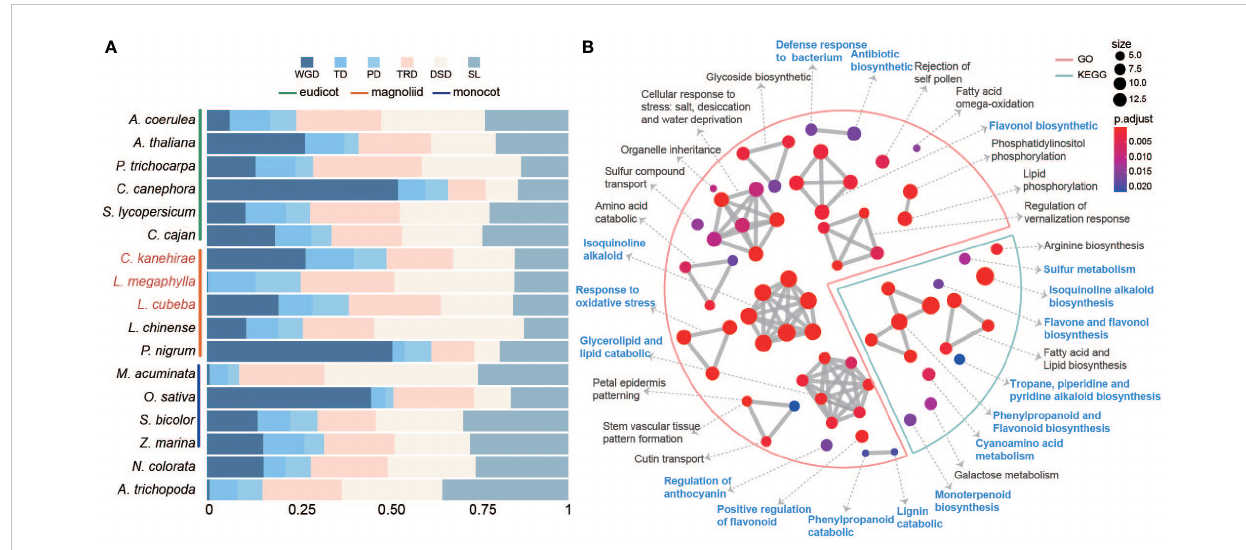
FIGURE 3 The expansion of duplicated genes. (A) The stacked bar chart shows the proportion of genes derived from fi ve duplication types (WGD whole- genome duplication, TD tandem duplication, PD proximal duplication, TRD transposed duplication and DSD dispersed duplication). (B) GO and KEGG functional enrichment analysis of expanded genes arising from tandem and proximal duplicates (TD/PD) in Lauraceae. The red line represents GO enrichment and the blue line represents KEGG enrichment. Blue letters indicate terms related to wood decay